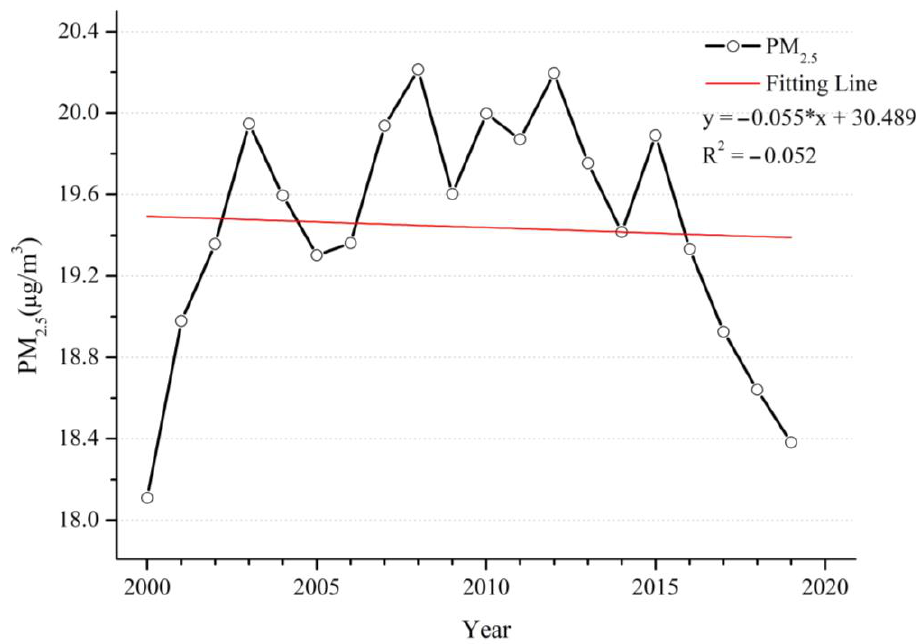
Figure 2. Time series of annual mean PM 2 . 5 concentrations from 2000 to 2019.